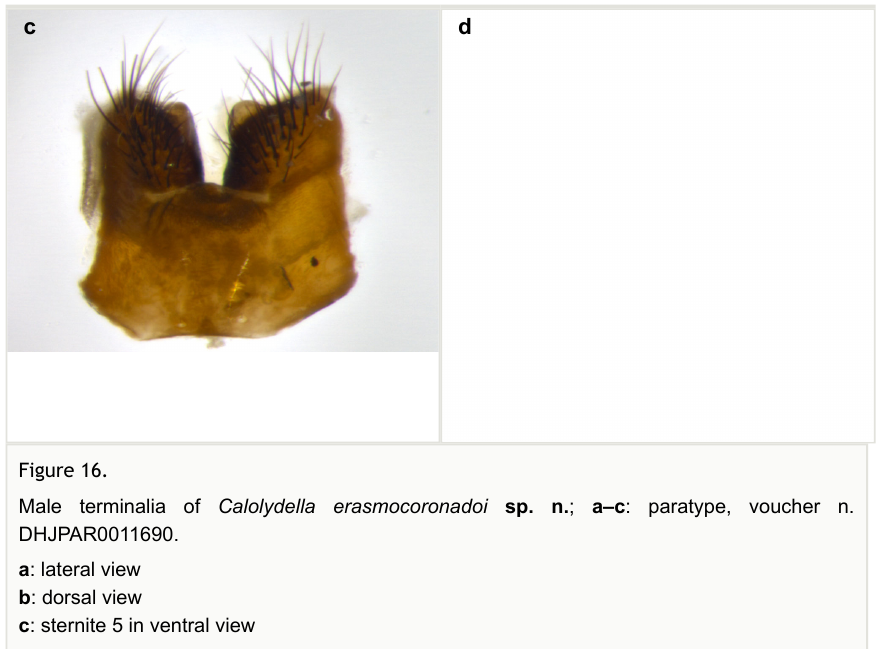
Male terminalia of Calolydella erasmocoronadoi sp. n. ; a–c : paratype, voucher